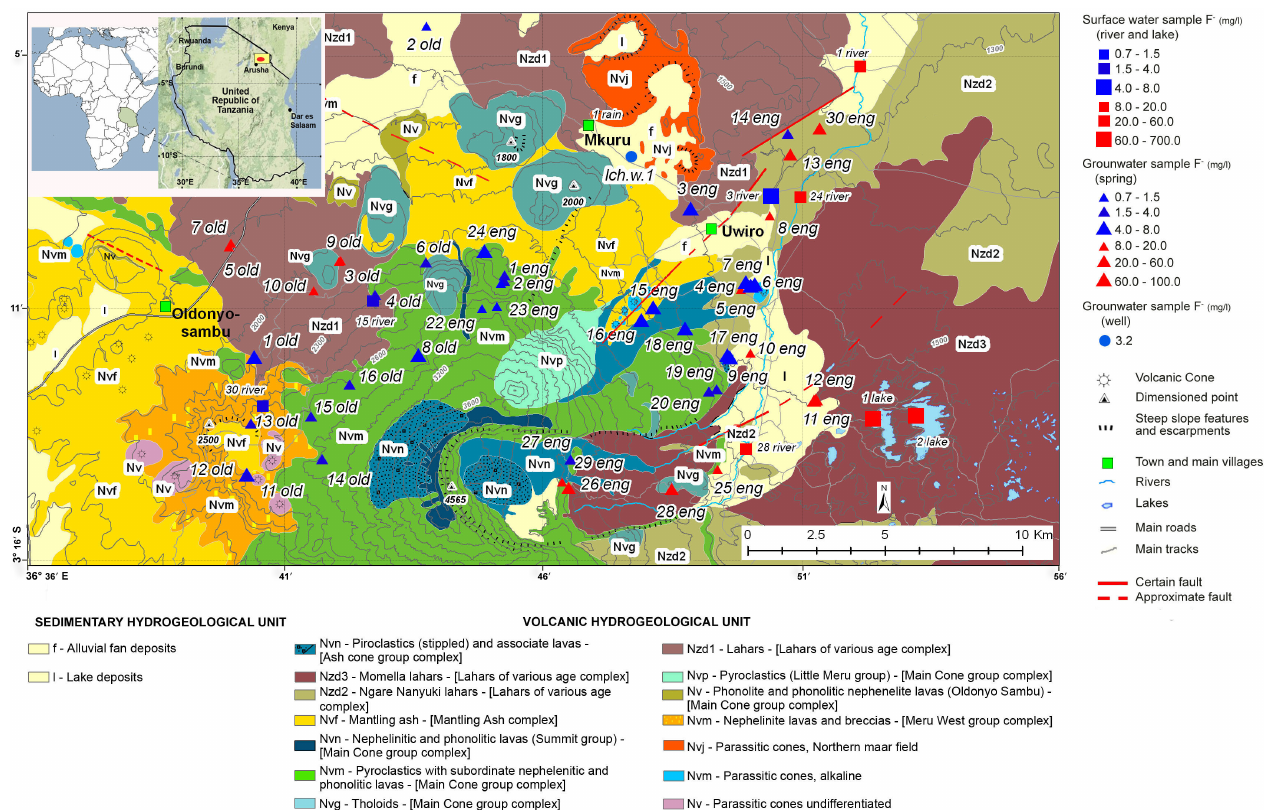
Fig. 1. Study area and related hydrogeological map indicating the location of water